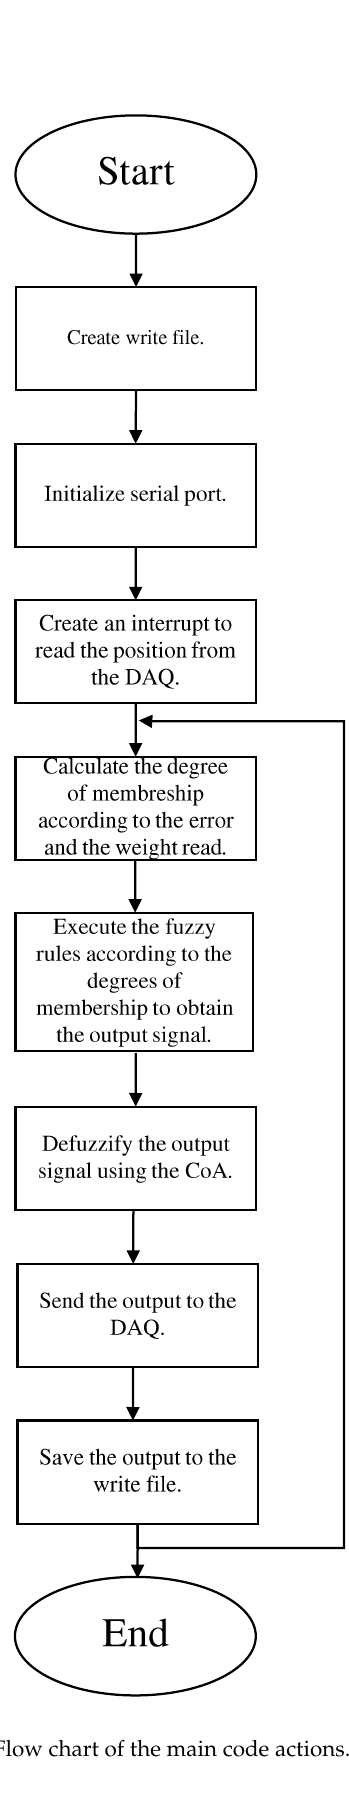
Figure 8. Flow chart of the main code